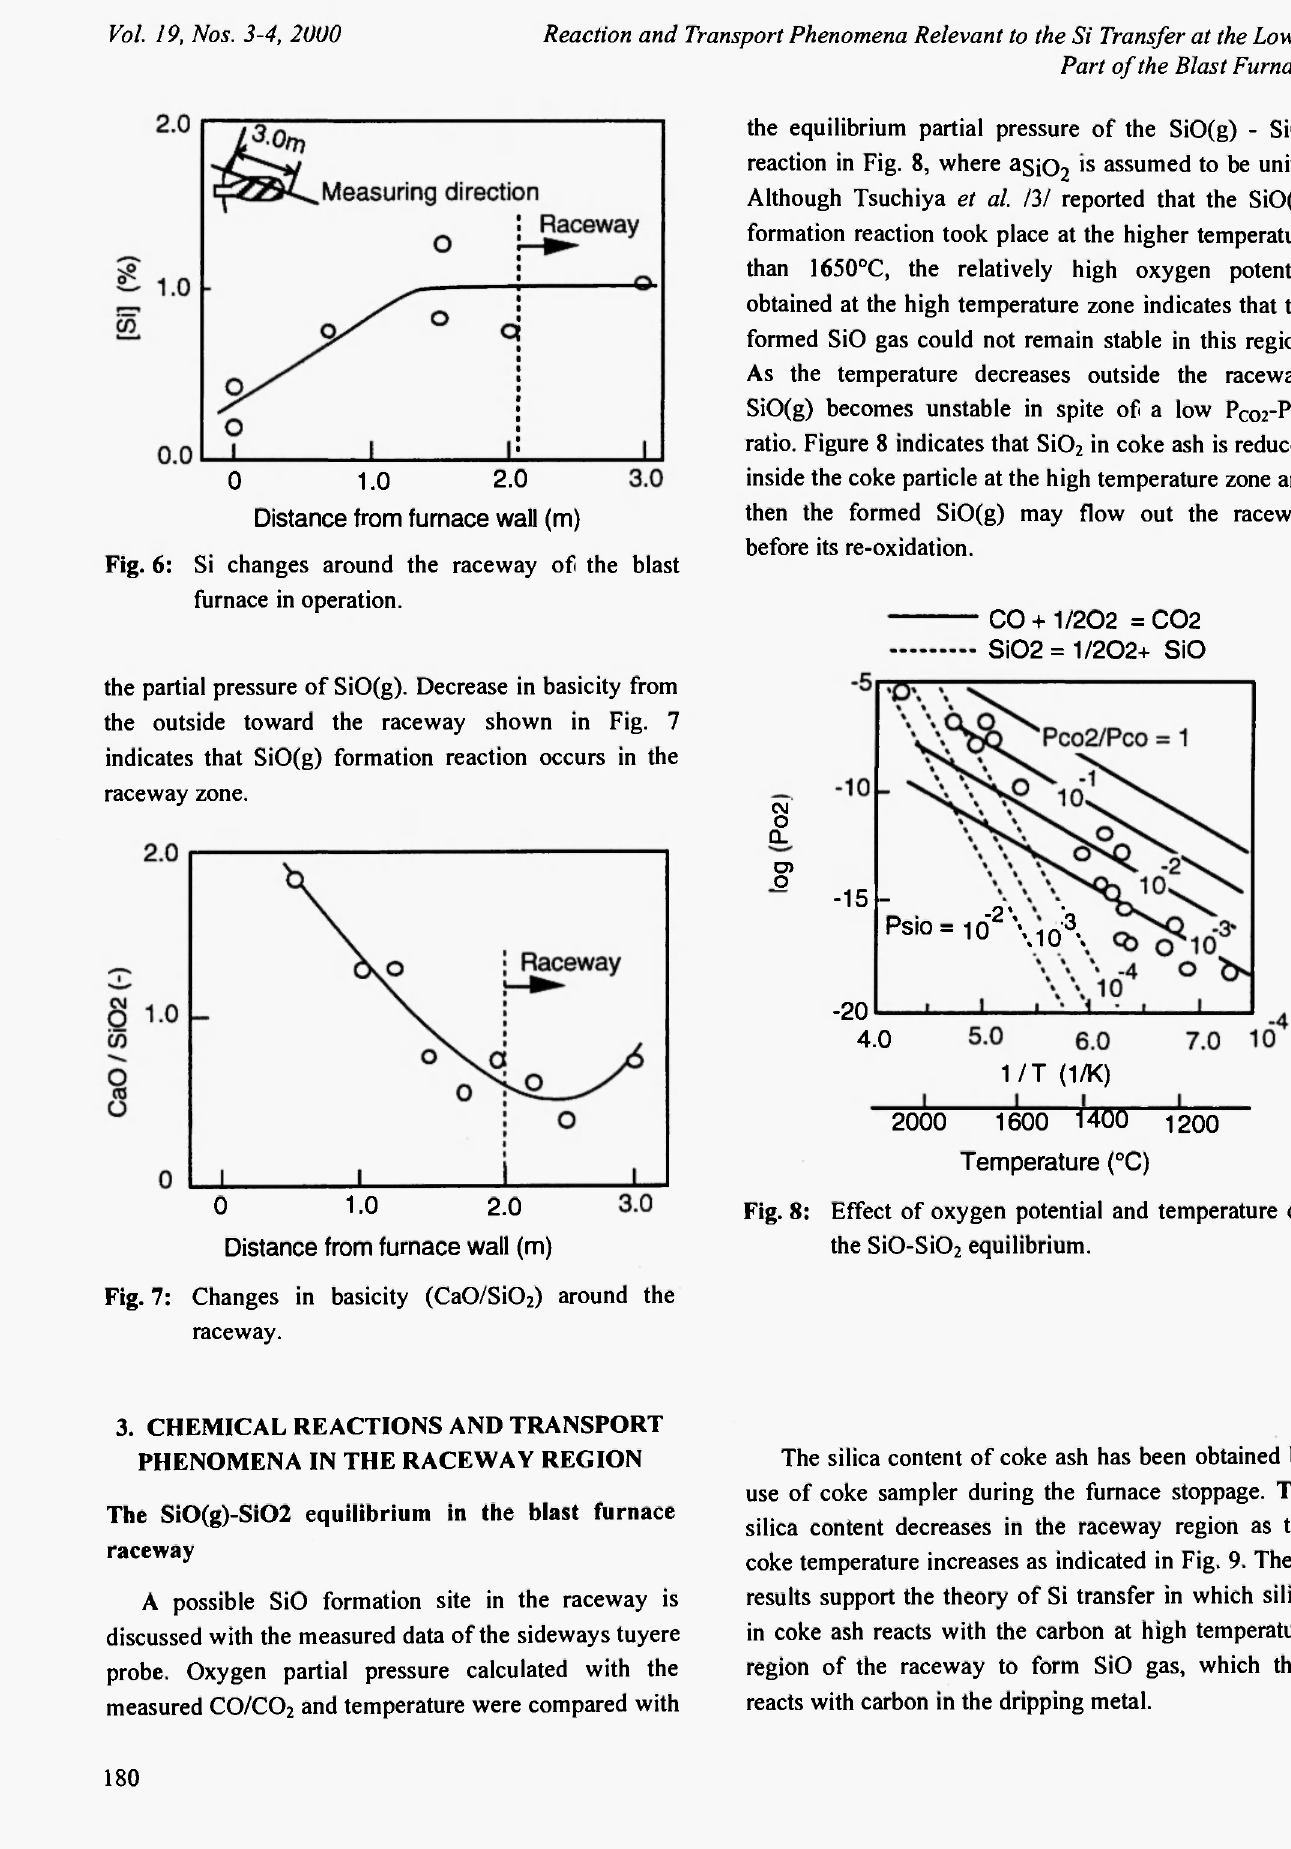
Fig. 8: Effect of oxygen potential and temperature on the Si0-Si0 2